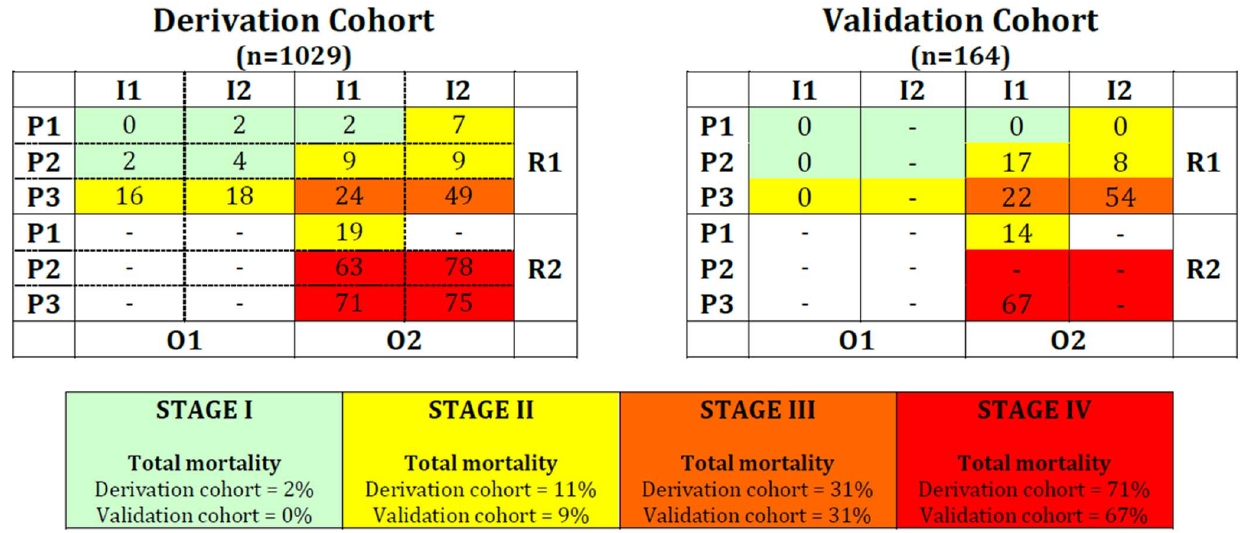
Figure 2. Different stages of PIRO obtained according to the different combinations of Predisposition (P1, P2, P3), Insult (I1, I2), Response (R1, R2) and Organ dysfunction scores (O1, O2). The numbers represent the mortality rate for each state, e.g., the state P 1 I 1 R 2 O 2 had a mortality of 19% in the derivation cohort and 14% in the derivation cohort. Only states with more than 5 patients were considered. The dashes ( 2 ) indicate that there was not enough patients in the respective state to evaluate mortality. doi:10.1371/journal.pone.0070806.g002 PLOS ONE |